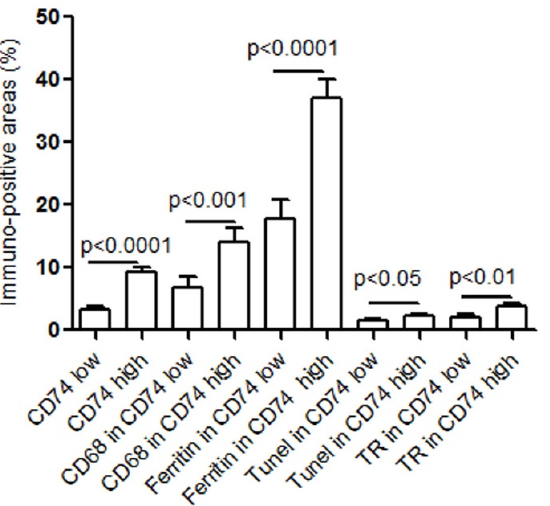
Figure 3. Lesions with higher levels of CD74 contain higher levels of macrophages, apoptosis, ferri ‐ tin, and thrombin receptor. The levels of CD74 in the lesions were divided in two groups by the median value. The CD74 levels ≤ median value was defined as CD74 low ( n = 31), while >median value was defined as CD74 high ( n = 30). The CD68, ferritin, TUNEL, and TR levels were further divided in two groups according to CD74 low or high for comparison.